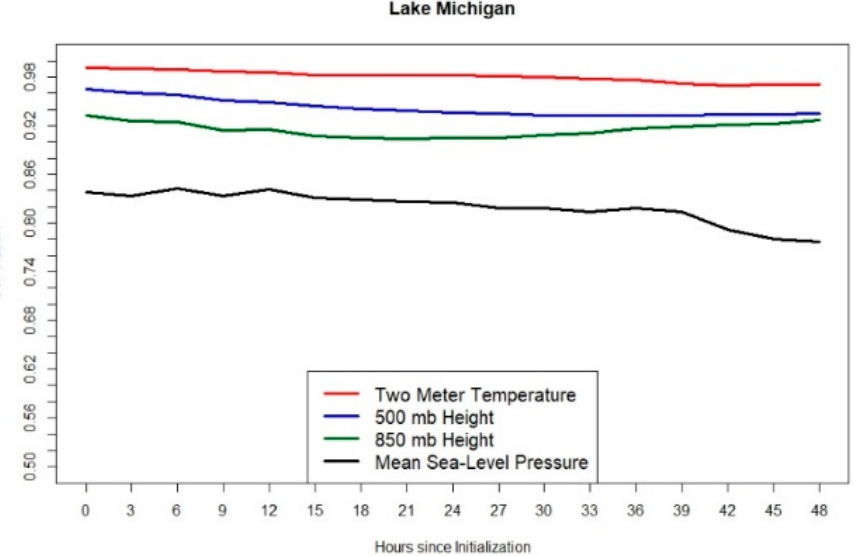
Figure 9. Average Pearson correlation coefficients between each listed spatial field for all four Lake Michigan clusters.